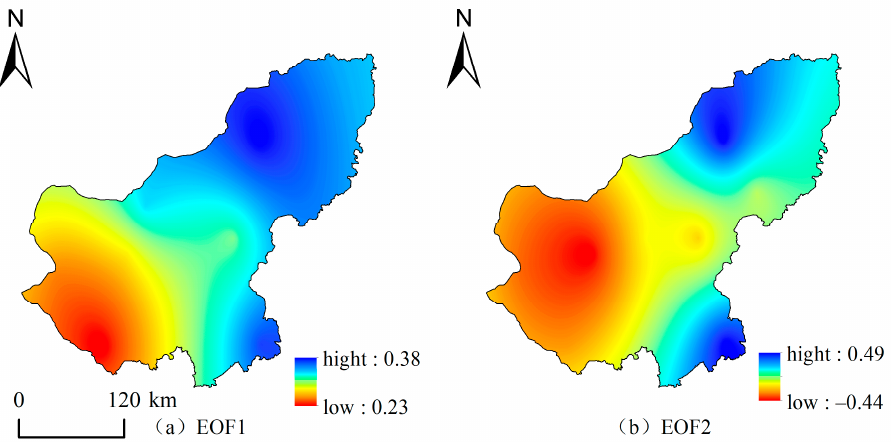
Figure 6. Spatial distribution of the first two eigenvectors of EDI from 1969 to 2018. ( a ) EOF first mode. ( b ) EOF second mode.